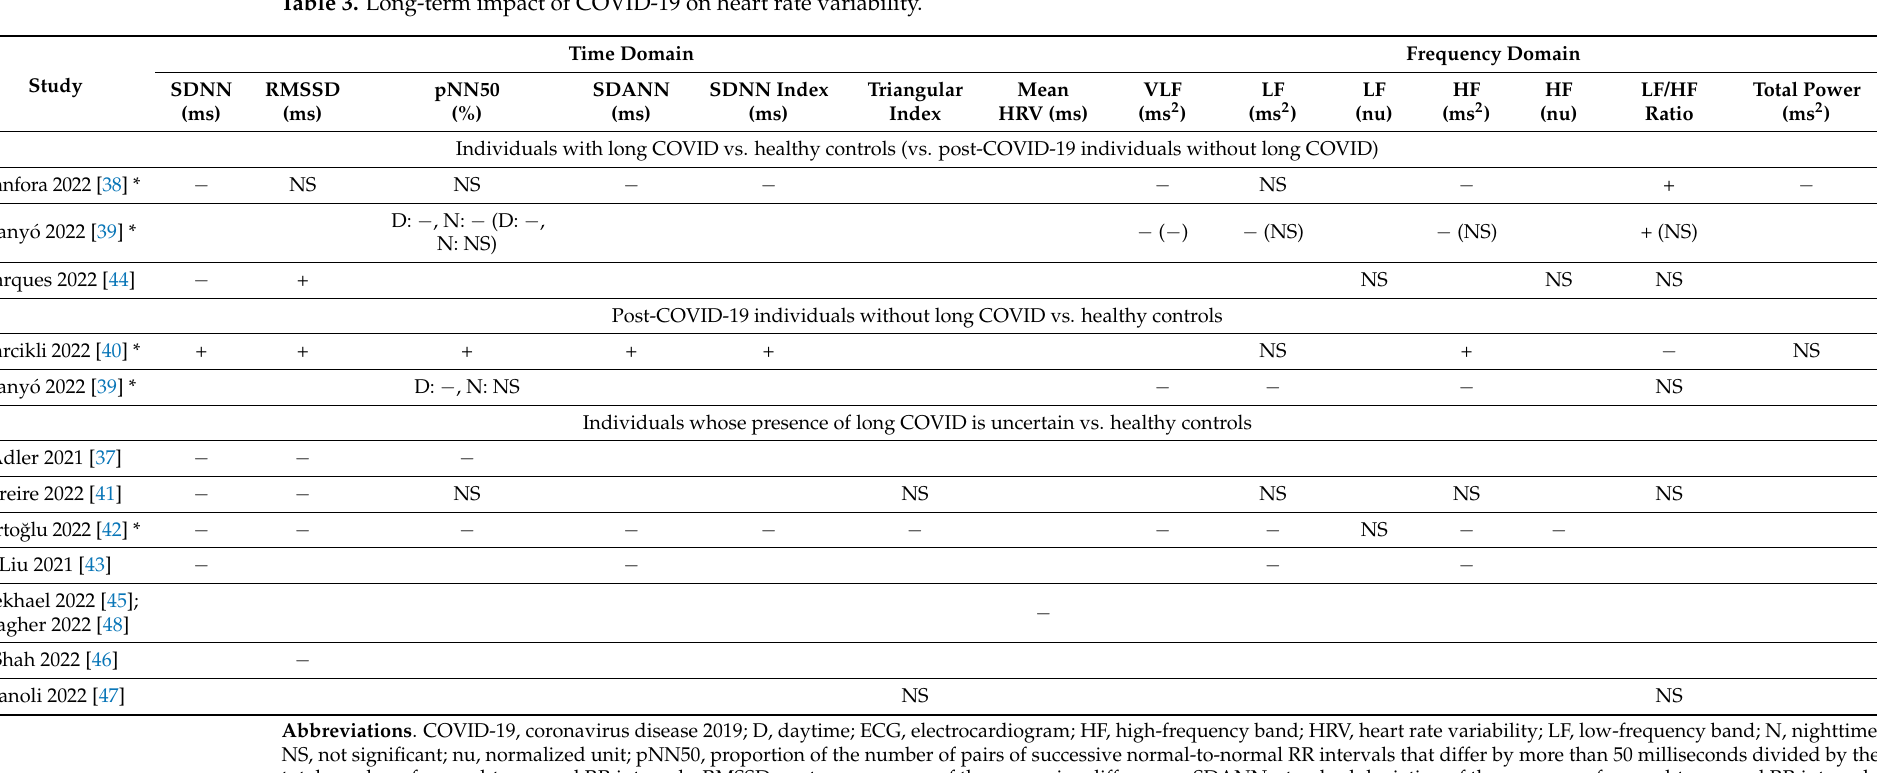
Table 3. Long-term impact of COVID-19 on heart rate